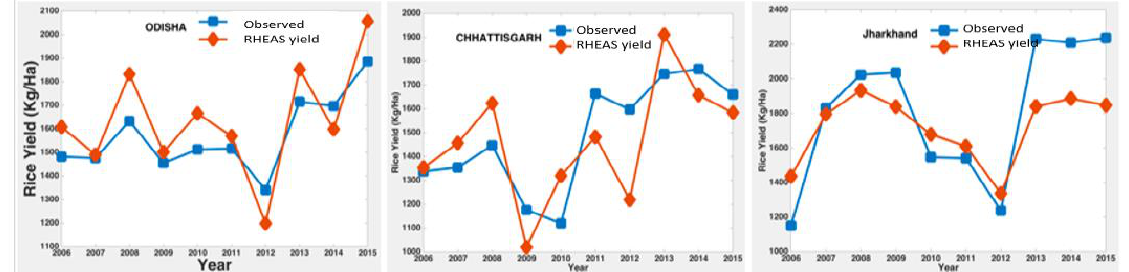
Figure 10 : Comparison of actual rice yields and RHEAS and M-DSSAT output yields for three states for year 2006 to year 2015.